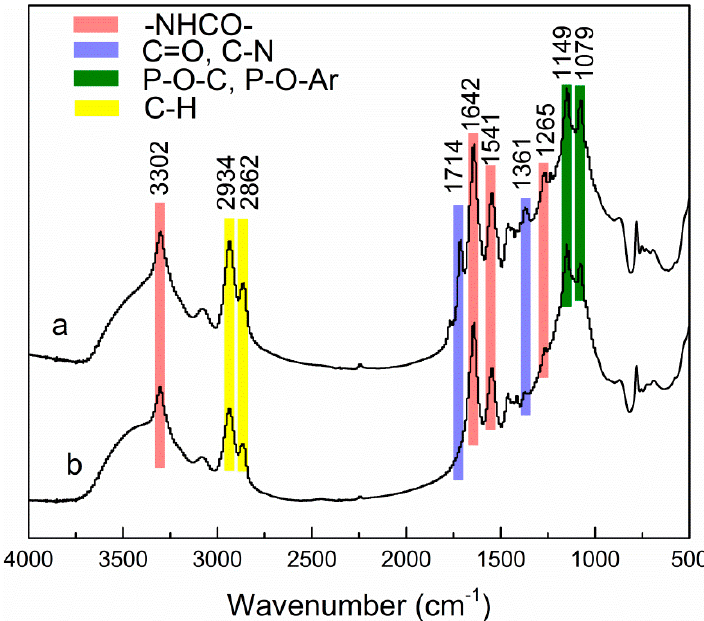
Figure 5. FTIR spectra of PA6 composites from cone tests ( a ) 5%API/7%ADP/GF/PA6; ( b ) 12%ADP/GF/PA6.